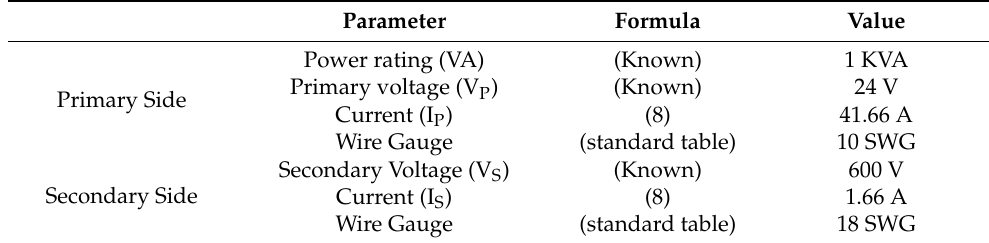
Table 2. Design Summary of Transformer